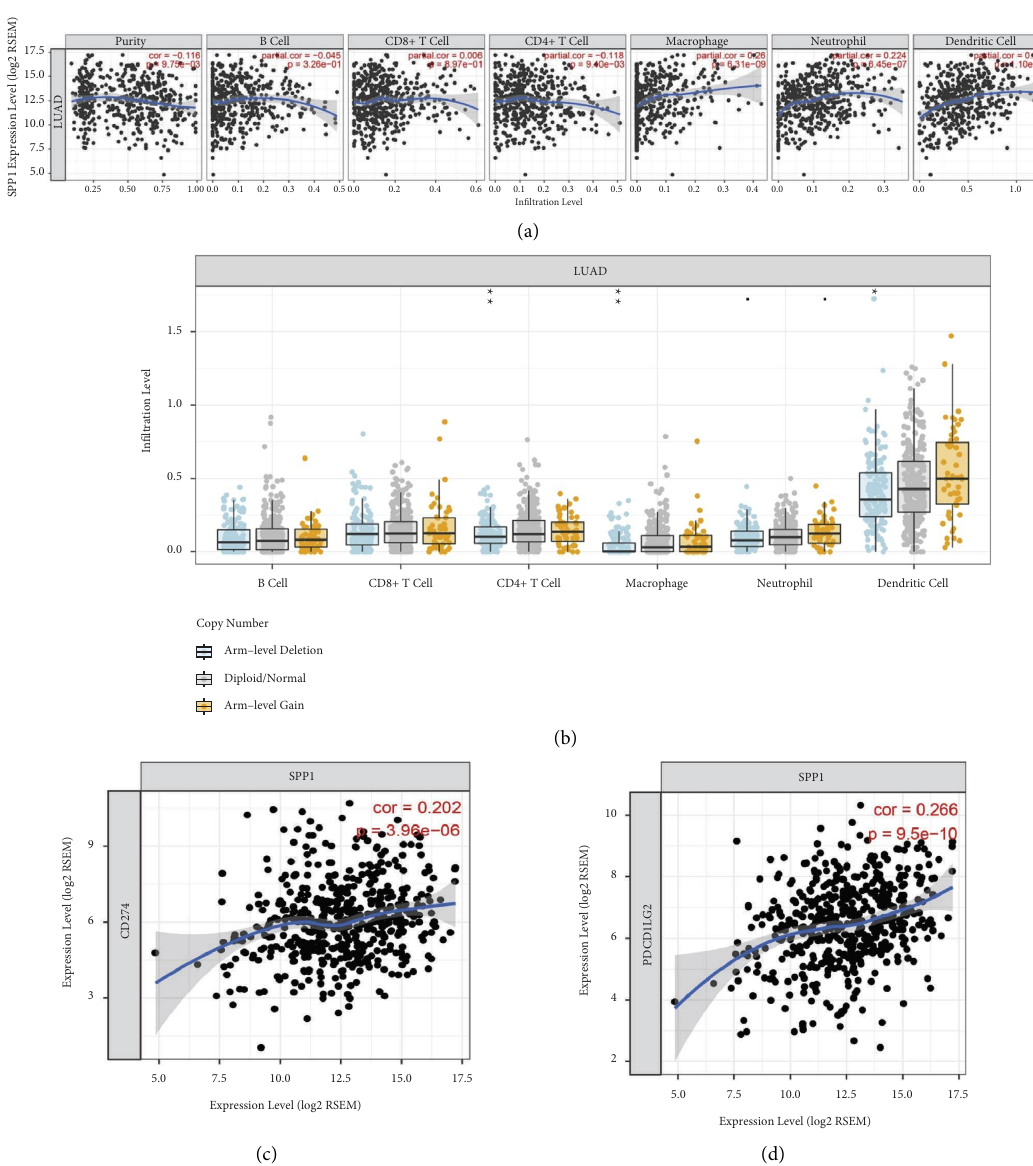
Figure 11: Immune correlation analysis in lung adenocarcinoma based on the TIMER website. (a) Relationship between SPP1 and immune cells. (b) Te expression of immune cells in lung adenocarcinoma (LUAD). (c) Relationship between SPP1 and CD274 checkpoints. (d) Relationship between SPP1 and PDCD1LG2